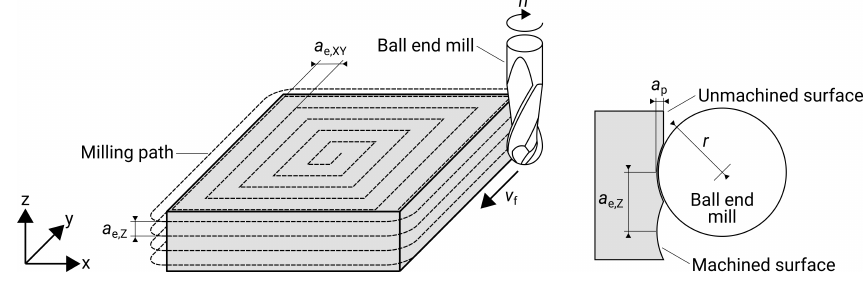
Figure 4. Milling strategy and parameters for a ball end mill. Table 3. Manufacturer’s settings for finishing as a reference and different levels for input parameters. Parameter